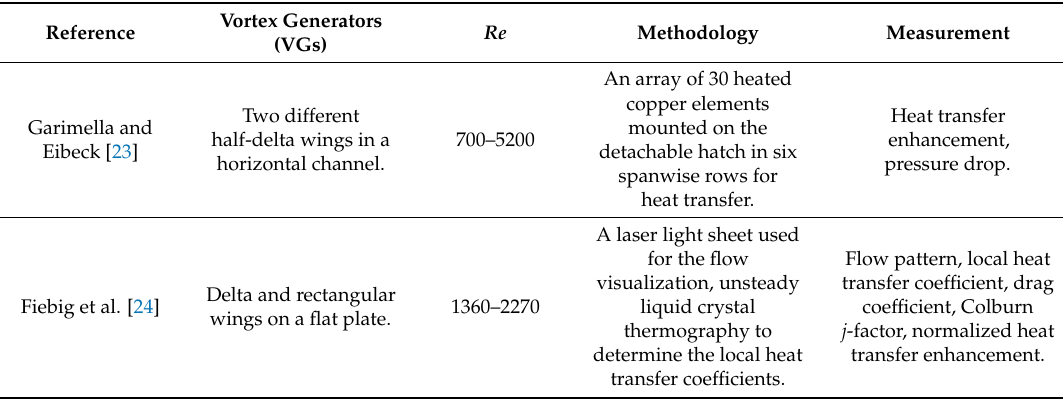
Table 1. Representative experimental investigations of airside thermohydraulic performance with vortex generators on heat transfer surfaces.